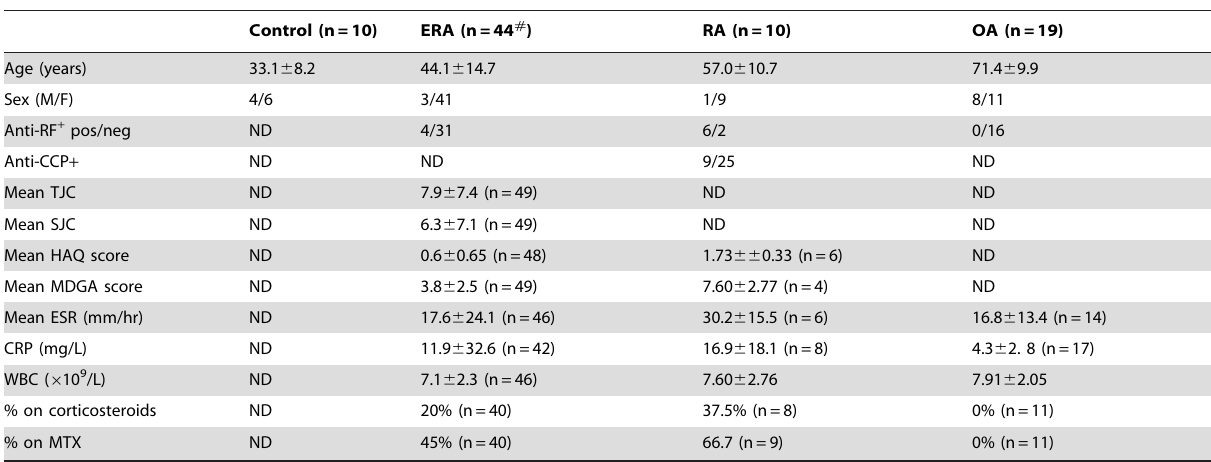
Table 3. Patient demographic and clinical characteristics